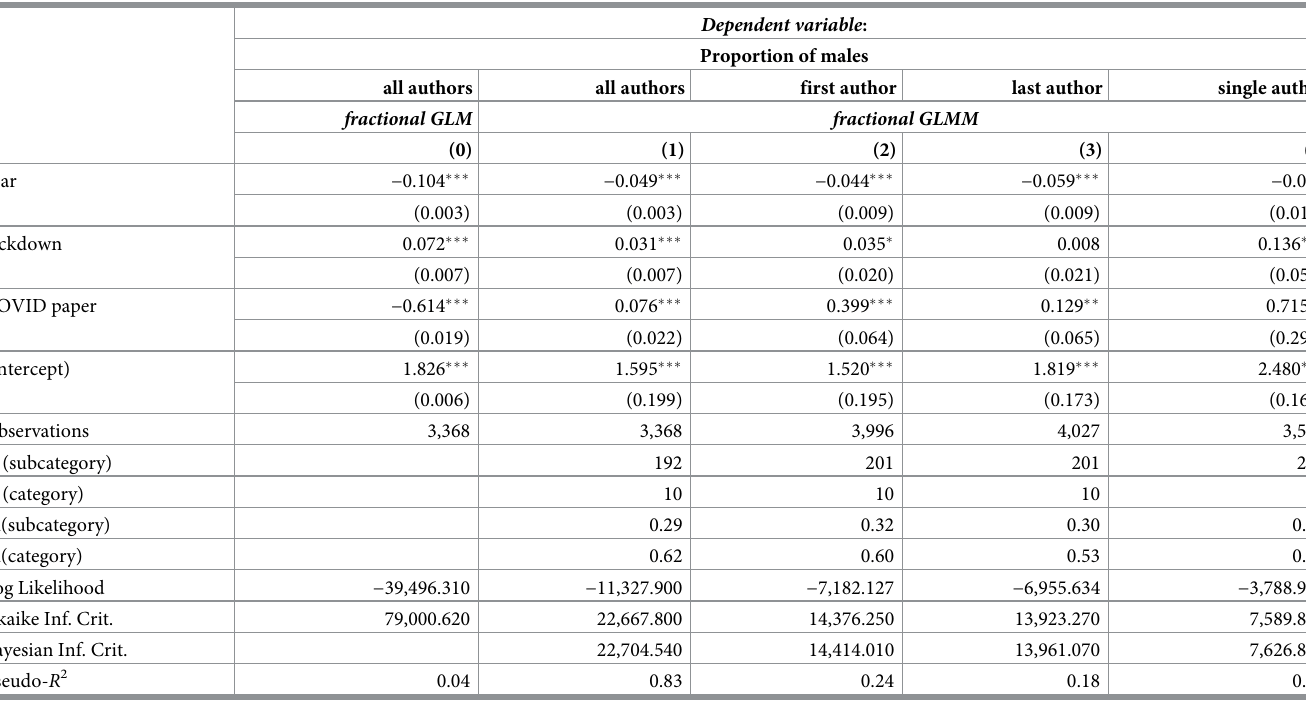
Table 3. Regression analysis results. Table of coefficients and summary statistics for the models